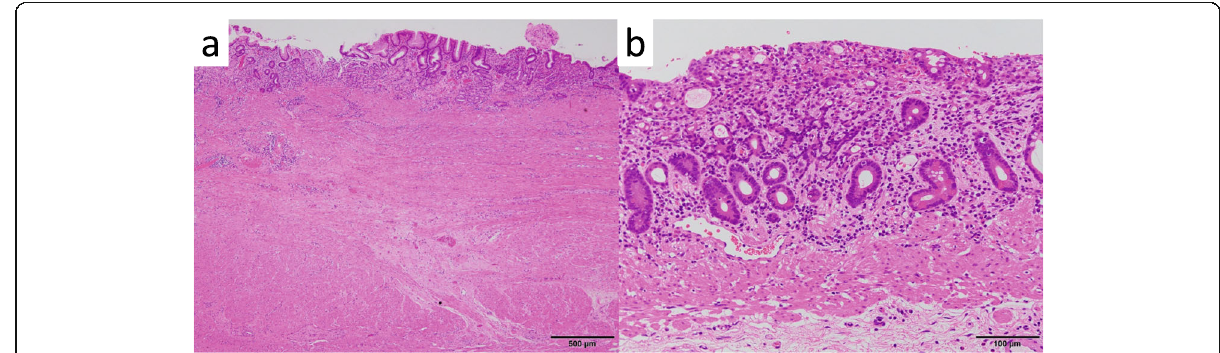
Fig. 3 Histopathological findings. Initial pathology showing intramucosal carcinoma without lymphatic and vascular invasion, and with fibrosis affecting all layers. a Hematoxylin-eosin staining, original magnification × 40. b Hematoxylin-eosin staining, original magnification ×